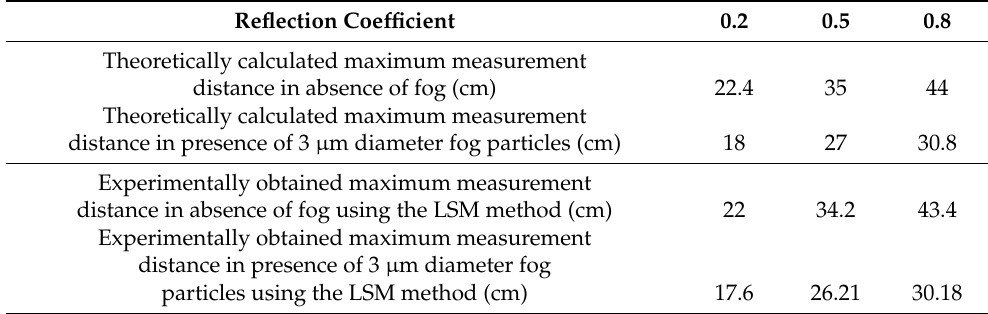
Table 2. Theoretically obtained maximum distance at which the measurement can still be performed vs. that experimentally obtained under the same conditions. Reflection Coefficient Theoretically calculated maximum measurement distance in absence of fog